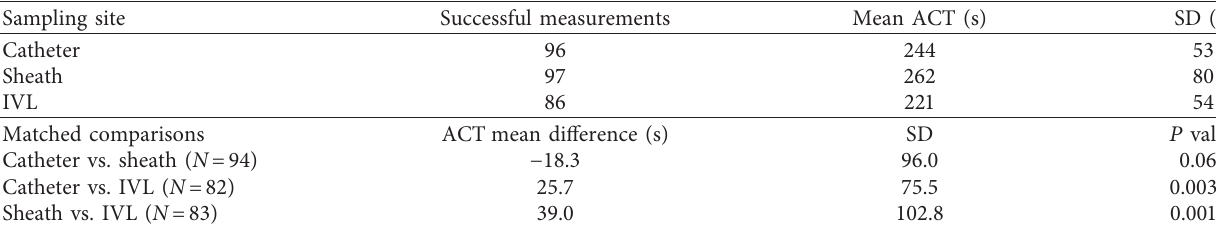
Table 2: Sample site comparison ∗ .